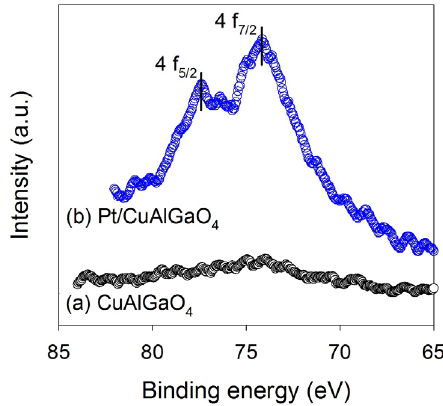
Figure 5. The Pt 4f X-ray photoelectron spectroscopy (XPS) spectra for ( a ) CuAlGaO 4 and ( b ) 1 wt % Pt/CuAlGaO 4 photocatalysts.